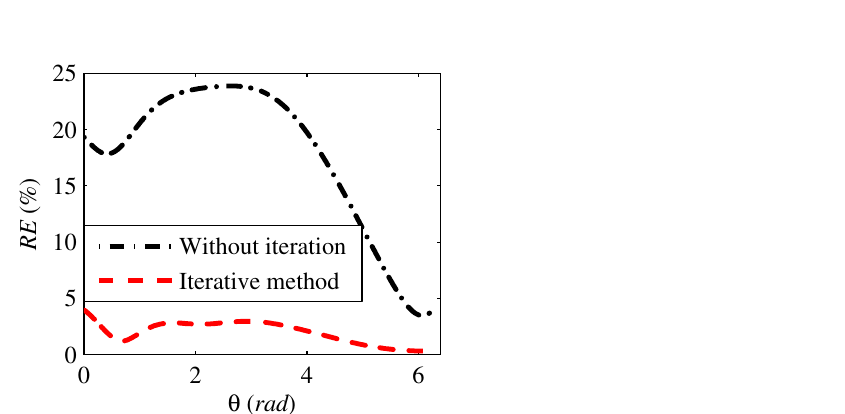
Figure 3. The curve of Δx ( a ), Δy ( b ), and Δz ( c ) versus θ.